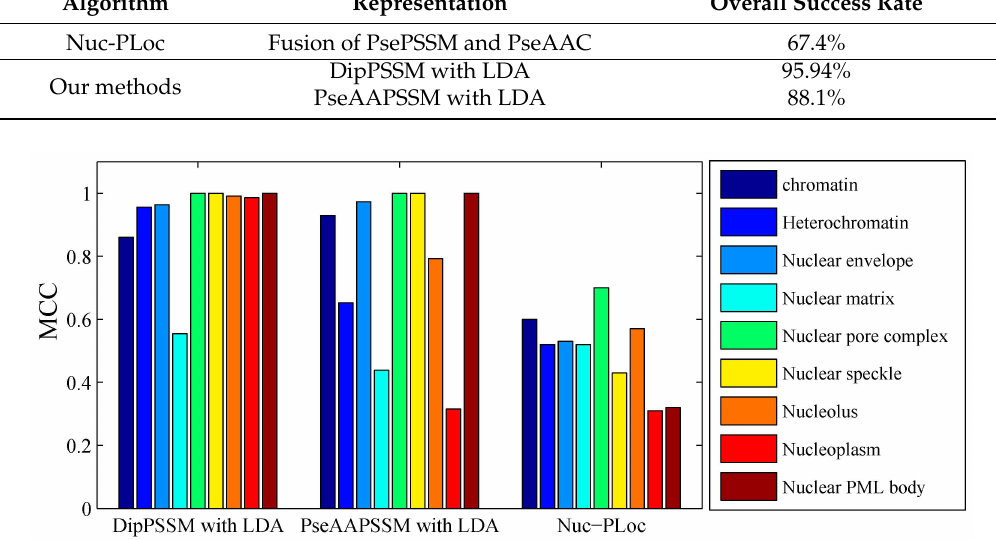
Figure 8. Comparison of MCC performance on Dataset 1 among our proposed methods with